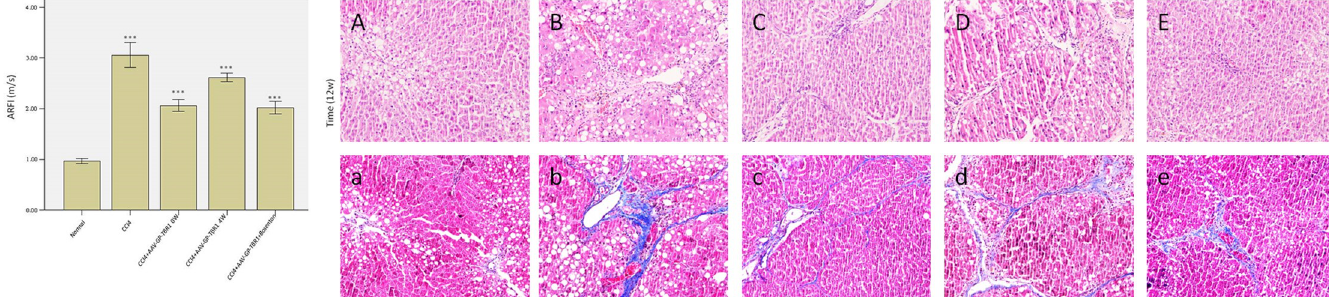
Fig 6. a. Comparison of the elasticity values of the different groups. b. Comparison of the H.E. and Masson’s staining of the different groups(A-E: H.E. staining A: Nomal; B: CCl4; C: CCl4+AAV-GP-T β R1-0W; D: CCl4+AAV-GP-T β R1-4W; E:CCl4+AAV-GP-T β R1 +Bosentan /a-e: Masson’s staining a: Nomal; b:CCl4; c:CCl4 +AAV-GP-T β R1-0W;d:CCl4+AAV-GP-T β R1-4W; e:CCl4+AAV-GP-T β R1 +Bosentan).